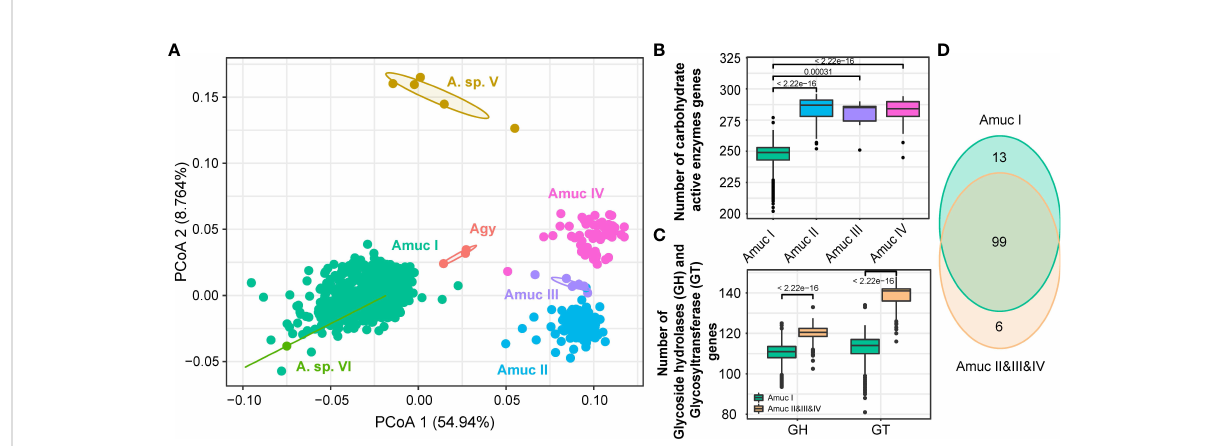
FIGURE 6 Comparison of CAZy functions among Akkermansia species and phylogroups. (A) PCoA analysis on the CAZymes families of 1,211 strains. (B, C) Boxplot showed the content comparison of CAZy enzyme-related genes annotated by the four phylogroups (B) and glycosyltransferase